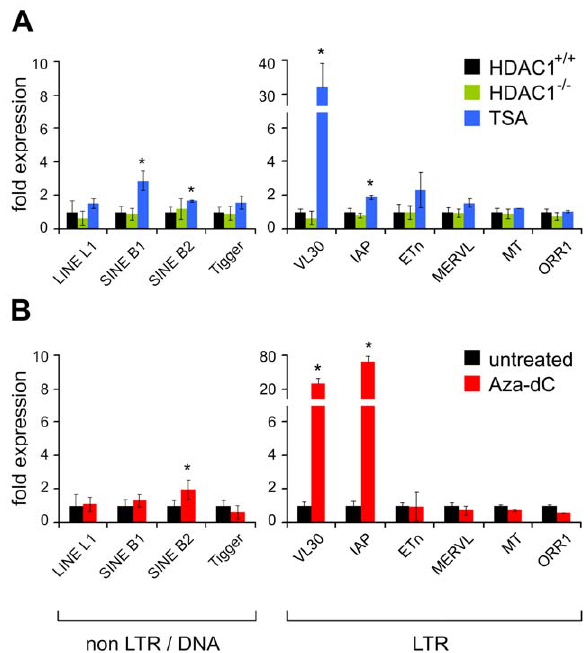
Figure 3. Effect of TSA and Aza-dC treatment on the expression of transposable elements. (A) Logarithmically growing fibroblasts show increased mRNA expression levels of VL30 LTR elements when treated with TSA. Expression levels were determined with qRT-PCR. Values are normalised to HPRT expression and are shown relative to the expression in untreated HDAC1 + / + fibroblasts. Treatment as in Figure 2. N=3; 6 SD *p , 0.05. (B) Aza-dC causes high level induction of VL30 and IAP LTR element expression. N=3; 6 SD *p ,